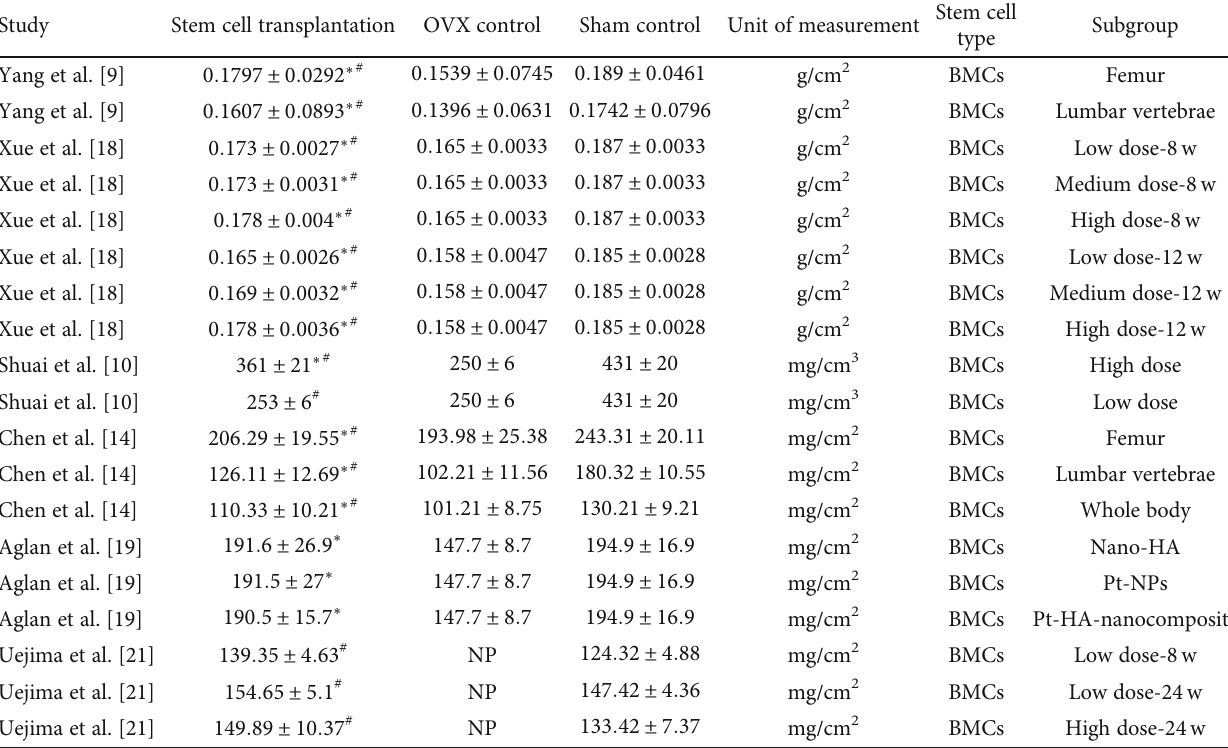
Table 3: Basic information about the included studies containing